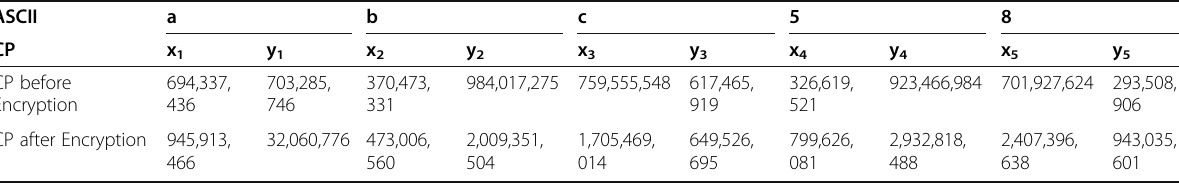
Table 3 Hash function encryption (example) ASCII a